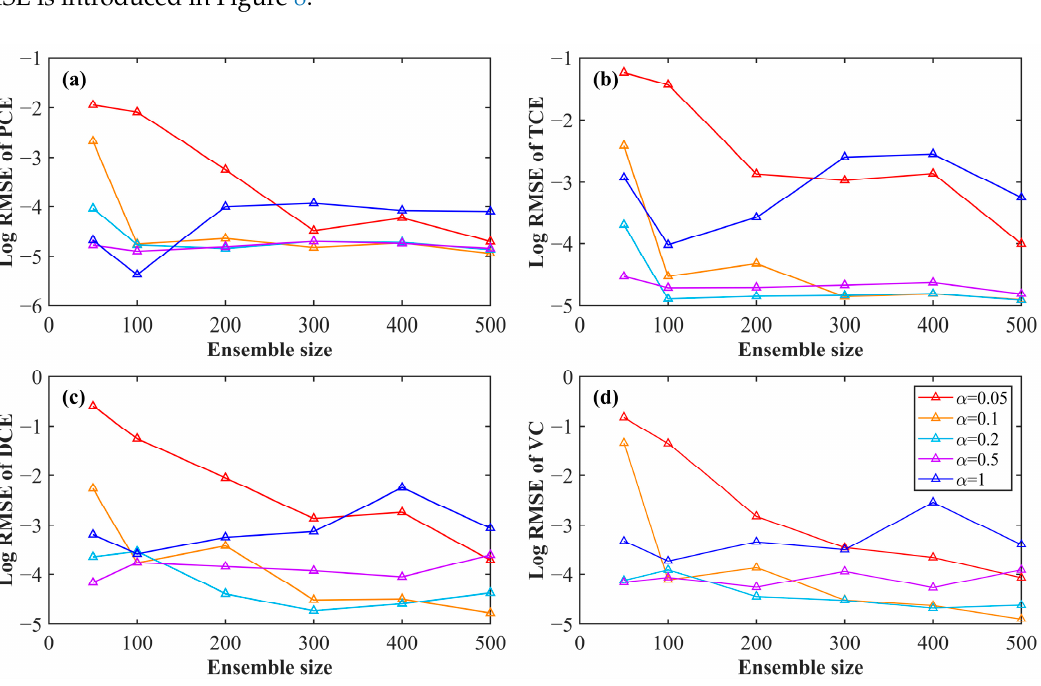
Figure 8. ( a ), ( b ), ( c ) and ( d ) represents the log-transformed root-mean-square error (RMSE) of Figure 8. ( a – d ) represents the log-transformed root-mean-square error (RMSE) of concentration concentration measurements of PCE, TCE, DCE and VC at the third iteration, respectively. Different measurements of PCE, TCE, DCE and VC at the third iteration, respectively. Di ff erent triangles triangles represent the log-RMSE for different combinations of (cid:2009) and (cid:1840) (cid:3032) . Different colored lines represent the log-RMSE for di ff erent combinations of α and N e . Di ff erent colored lines denote the denote the variation of log-RMSE with the increase of (cid:1840) (cid:3032) when the value of (cid:2009) is fixed. The number variation of log-RMSE with the increase of N e when the value of α is fixed. The number of iterations is of iterations is set to 10 for the ILUES algorithm. set to 10 for the ILUES